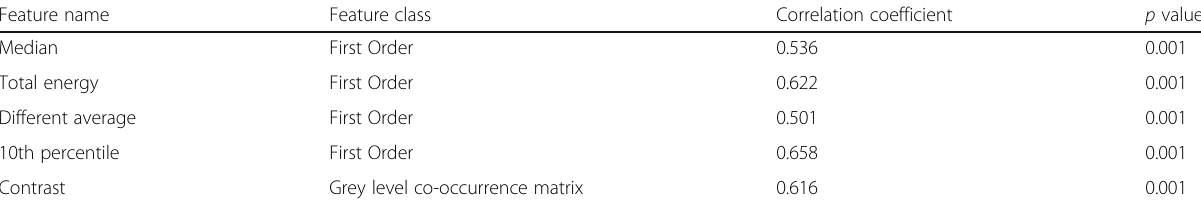
Table 3 Values of the five features parameters with a correlation coefficient > 0.5 and p <